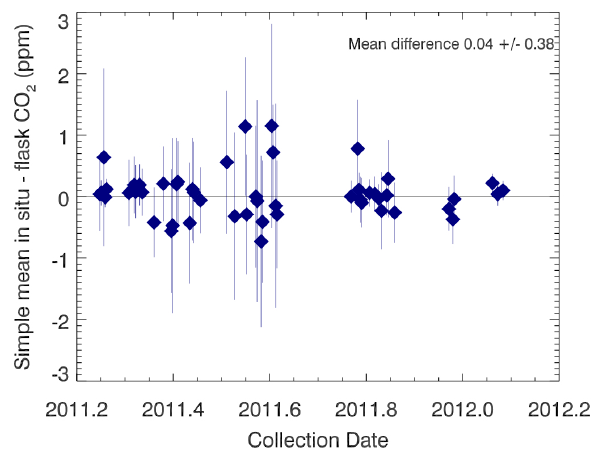
Fig. 7. Difference between in situ mean and flask CO 2 mole fraction for 50 flasks sampled at two sites near Indianapolis. Error bars are the standard deviation of the in situ values during the sampling time. Mean difference is